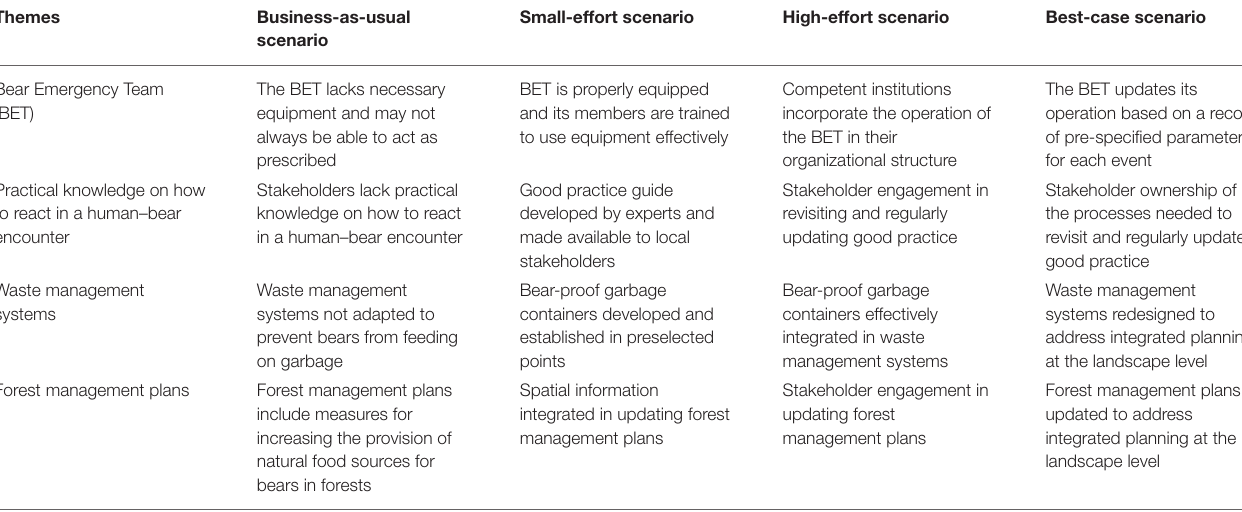
TABLE 3 | Template for participatory scenario development for bears approaching human settlements.